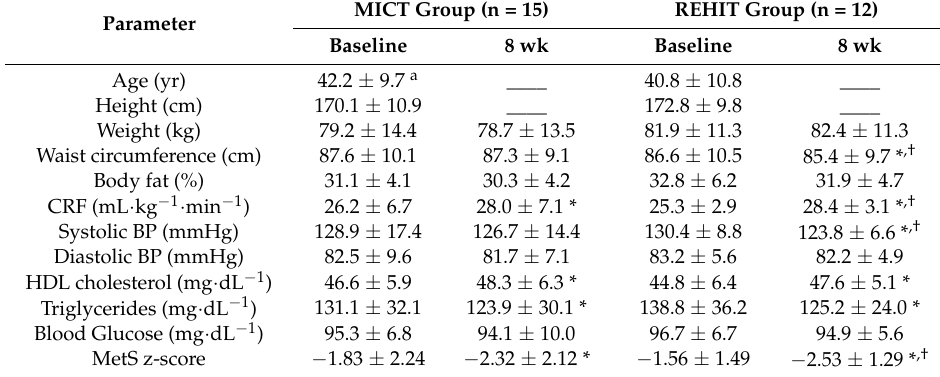
Table 1. Physical and physiological characteristics at baseline and 8 wks for REHIT and MICT groups.